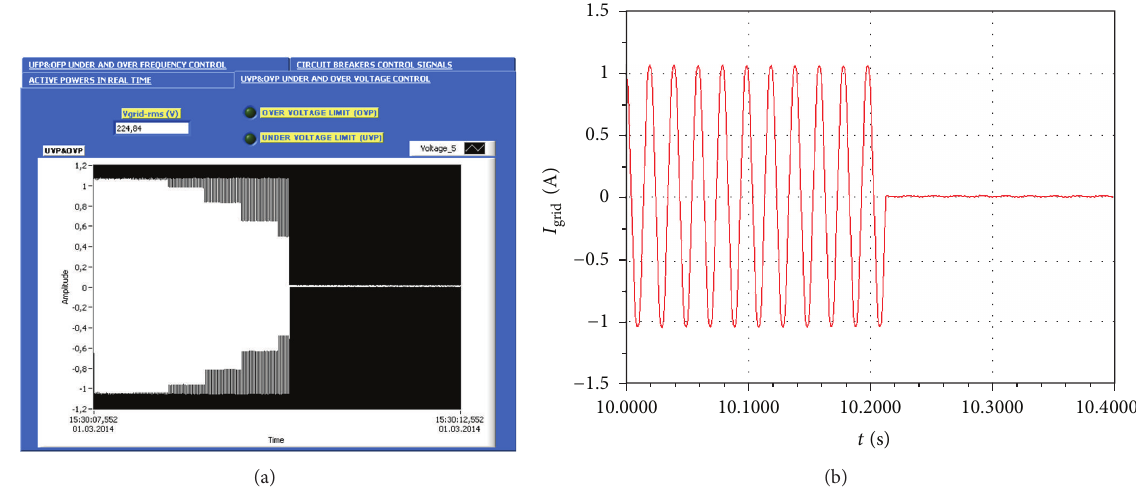
Figure 20: Grid current change for under frequency condition.